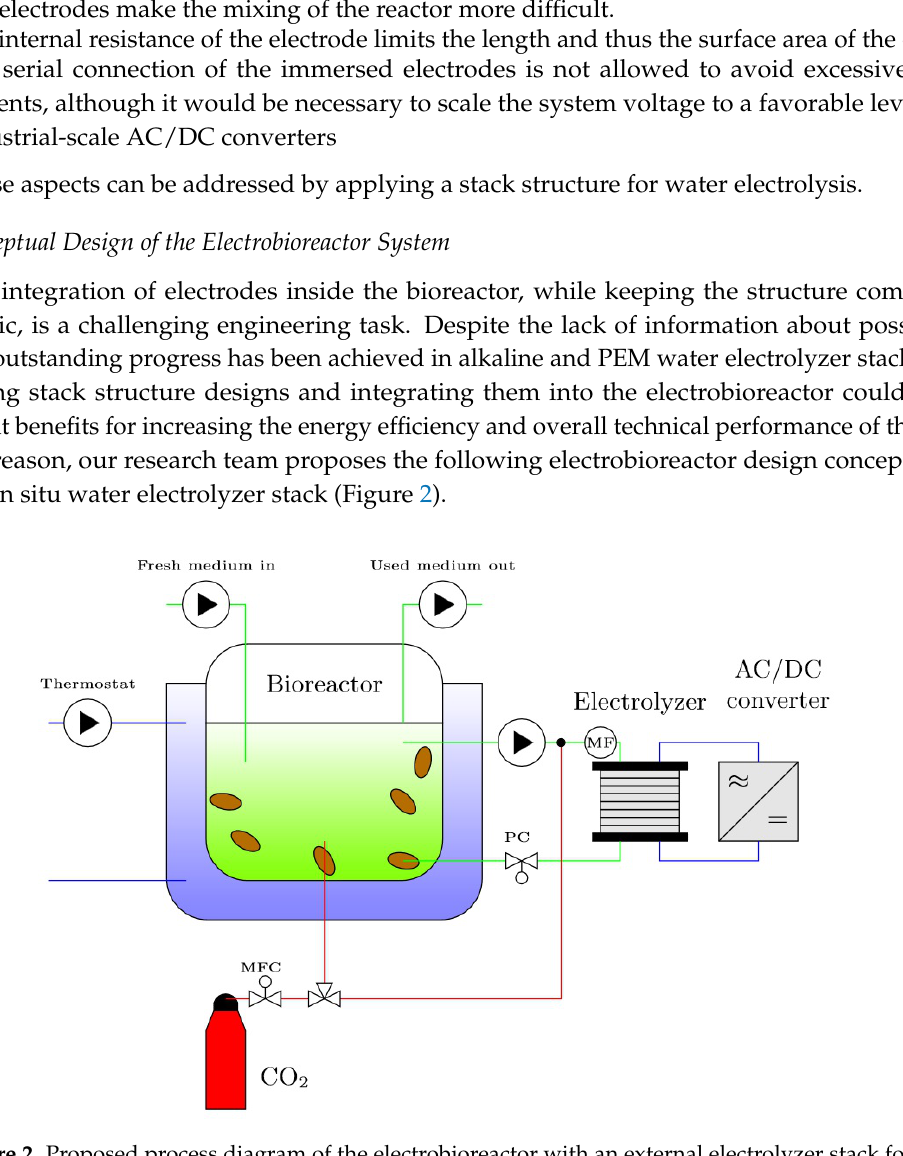
Figure 2. Proposed process diagram of the electrobioreactor with an external electrolyzer stack for the hybrid biological-inorganic (HBI)